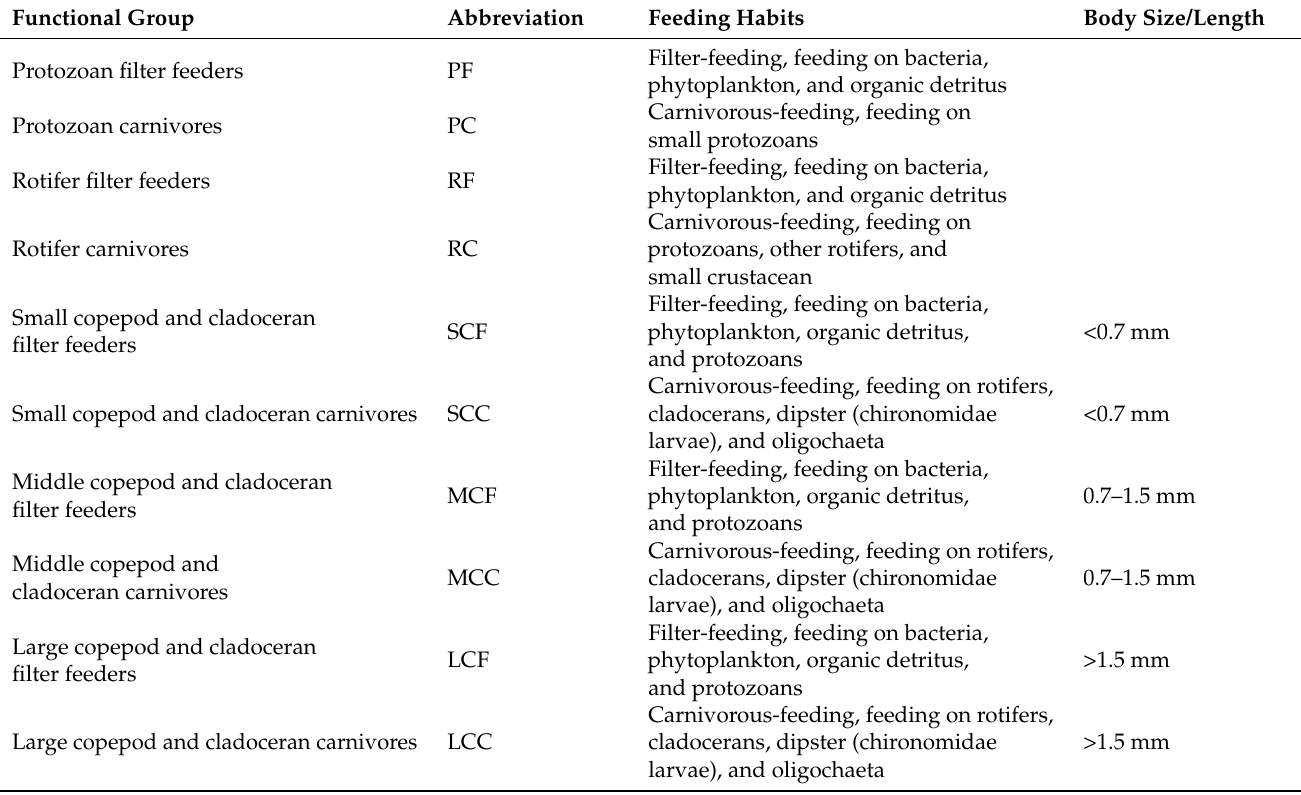
Table A1. The classification method of zooplankton functional groups in Danjiangkou